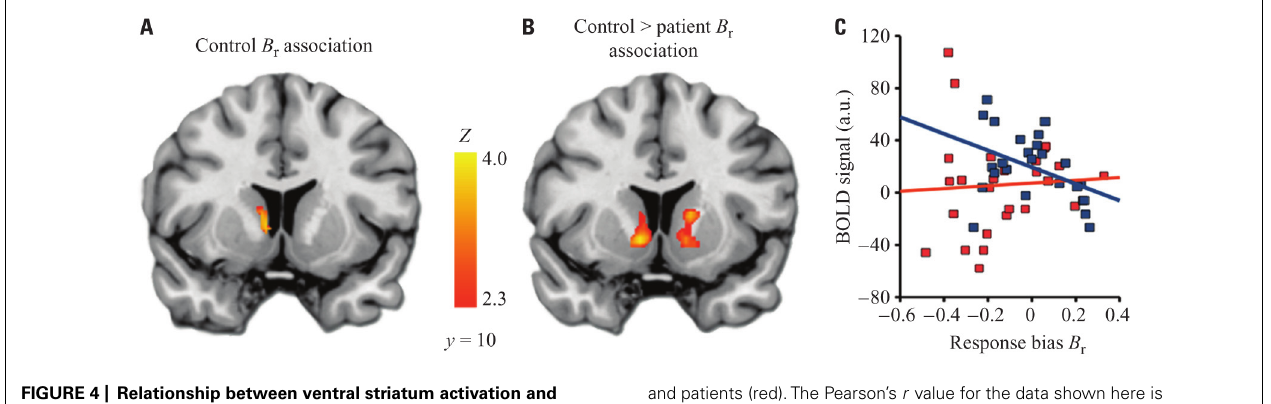
FIGURE 4 | Relationship between ventral striatum activation and response bias. (A) Cluster inVS ROI showing significant correlation between response bias and BOLD activation to HIT > baseline. An analogous within-group analysis in patients revealed no significant results. (B) Clusters showing significant differential correlation (controls > patients) to response bias. (C) Descriptive scatterplot showing mean BOLD activation in the cluster from (A) and response bias for controls (blue)